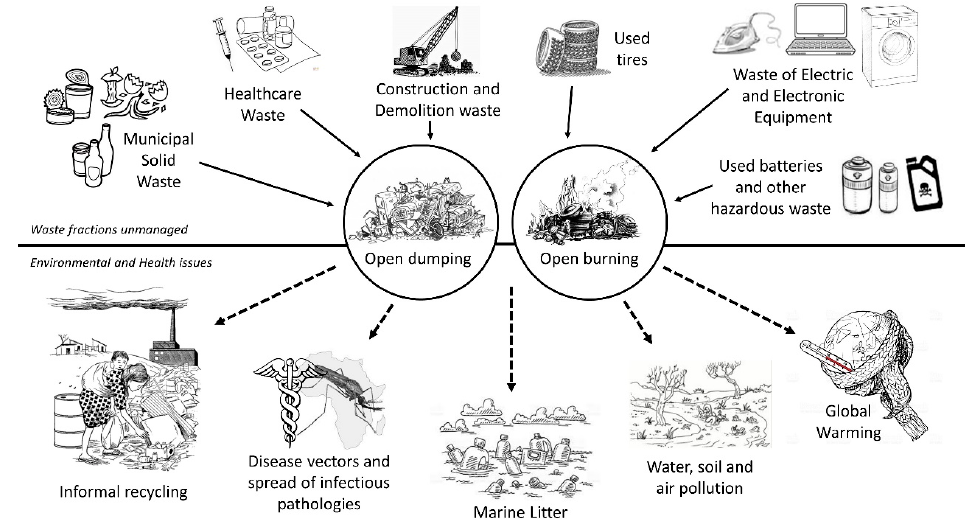
Figure 1. Theoretical framework of the review: source of contamination due to SW mismanagement.